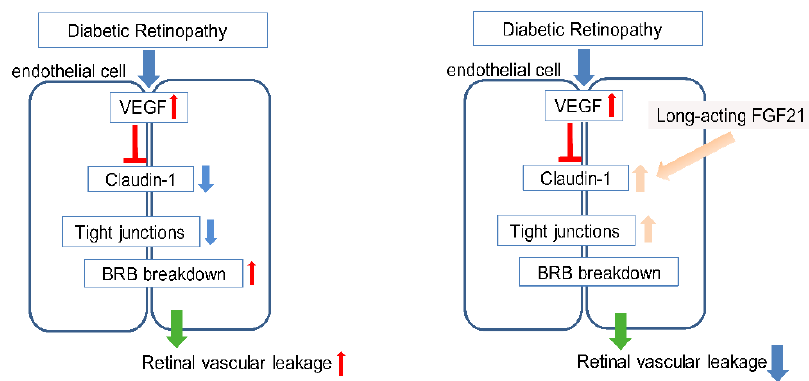
Figure 5. Schematic of the proposed pathway. VEGF suppresses Claudin-1 and disrupts the blood-retinal barrier (BRB) with increased vascular leakage in the retina. FGF21 may prevent VEGF-induced retinal vascular leakage by stabilizing tight junctions via Claudin-1.